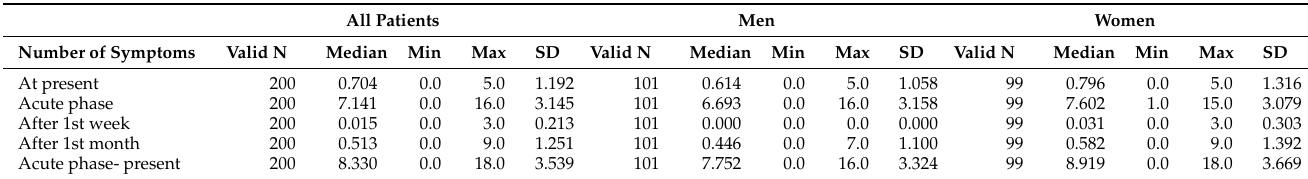
Table 5. Descriptive statistics for the number of symptoms related to COVID-19 by different times of the